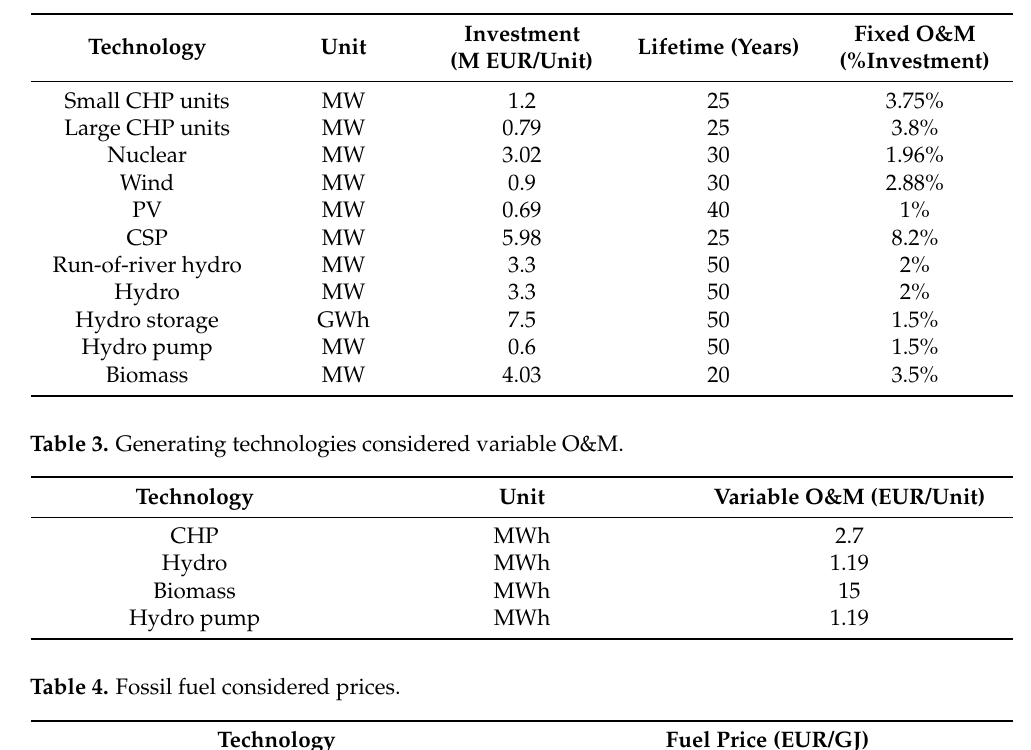
Table 2. Generating technologies considered investment, lifetime, and fixed O&M.